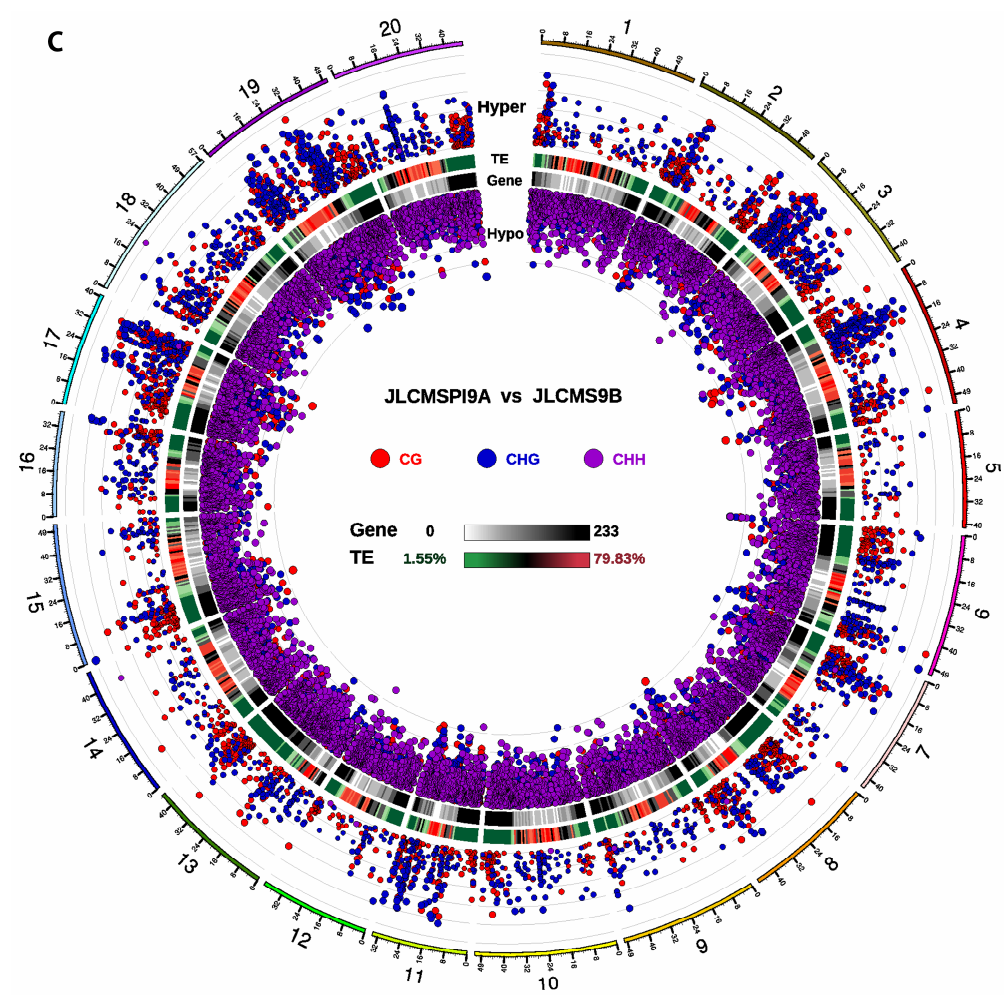
Figure 3. Cytosine methylation levels in three sequence contexts (CG, CHG and CHH) in differentially methylated regions (DMRs) as displayed by Circos maps. ( a ) JLCMS9A vs JLCMS9B; ( b ) JLCMSZ9A vs JLCMS9B; ( c ) JLCMS9A vs JLCMS9B. The red and blue dots denote hypermethylated and hypomethylated DMRs, respectively. The larger the dots, the greater the methylation differences between the two groups. From outside to inside, the circles are as follows: 1) Chromosome number and distance; 2) Hyper DMR log5 (|areaStat|), in the different positions the higher solid dots in the outward circle were more significan tdifference; 3) Heatmap of transposable elements (TEs) at chromosomal proportions (see color scale); 4) Gene density thermal map (Gene, see color scale), white to black indicates gene number from 0 to 233; and 5) Hypo DMR log5 (|areaStat|); in the different positions. The GO enrichment analysis of differentially methylated genes (DMGs) in JLCMS9A vs JLCMS9B in the CG background showed they were enriched in molecular function terms, while in JLCMSZ9A vs JLCMS9B and JLCMSPI9A vs JLCMS9B they also were enriched in biological process and cellular component terms compared with JLCMS9A (Figure 4).